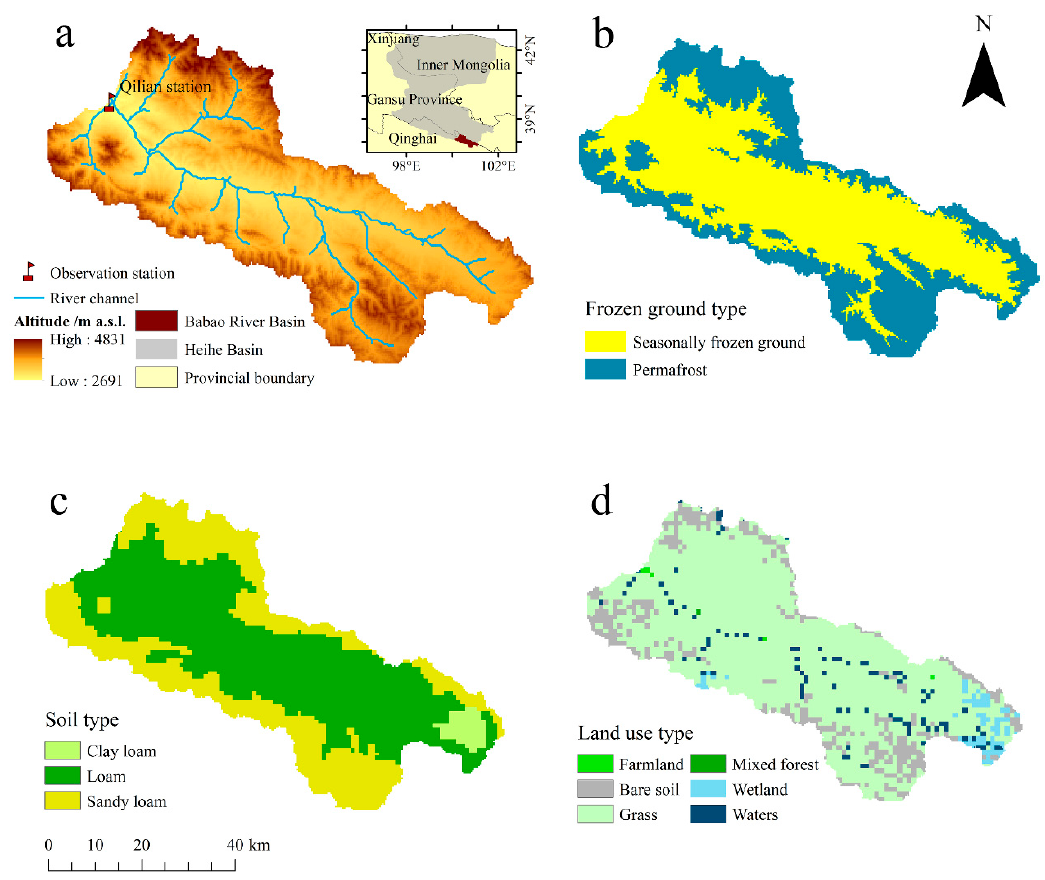
Figure 2. Maps showing the location, ( a ) topography, ( b ) frozen ground, ( c ) soil and ( d ) land use types in the Babao River Basin.